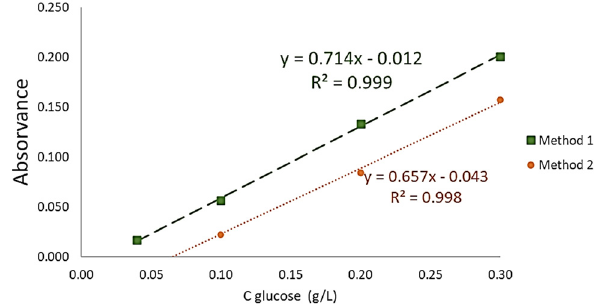
Figure 4: Calibration curves done with both methods under